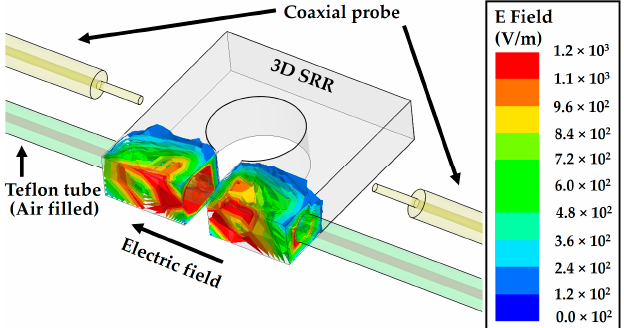
Figure 2. Electric field magnitude distribution at a resonance frequency of 2.56 GHz with an empty Teflon tube passing through a silver-coated 3D SRR resided in a cavity, which is capacitively coupled by a pair of coaxial probes. The high electric field in the proximity of the SRR split gap is ascribed to the high capacitance in the gap. A high frequency structural simulator (HFSS) is used for simulation analysis.